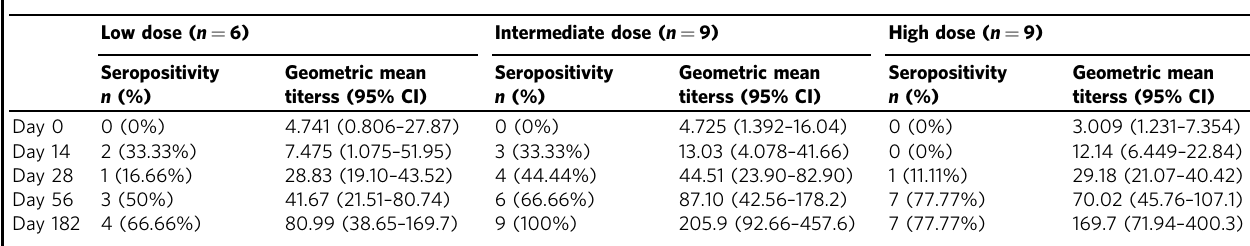
Table 4 CHIKV IgG response by standardized ELISA to E2 protein.